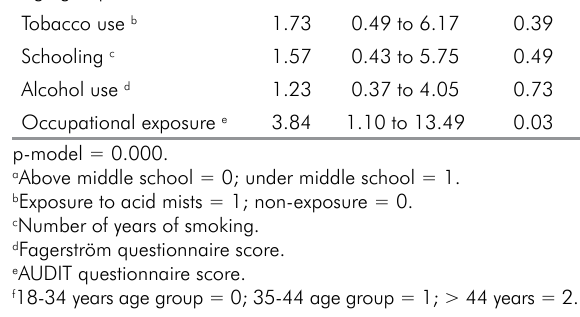
Table 8. Unconditional logistic regression analysis of the presence of NCCLs.